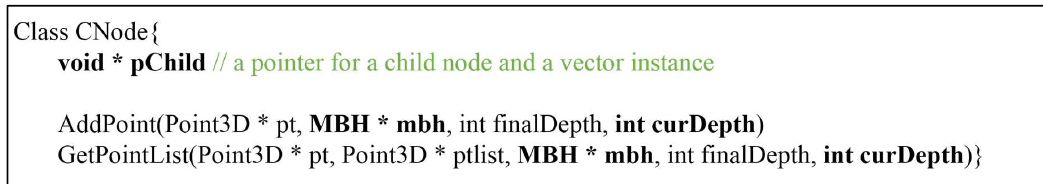
Figure 2. Pseudo codes of a compact form CNode.